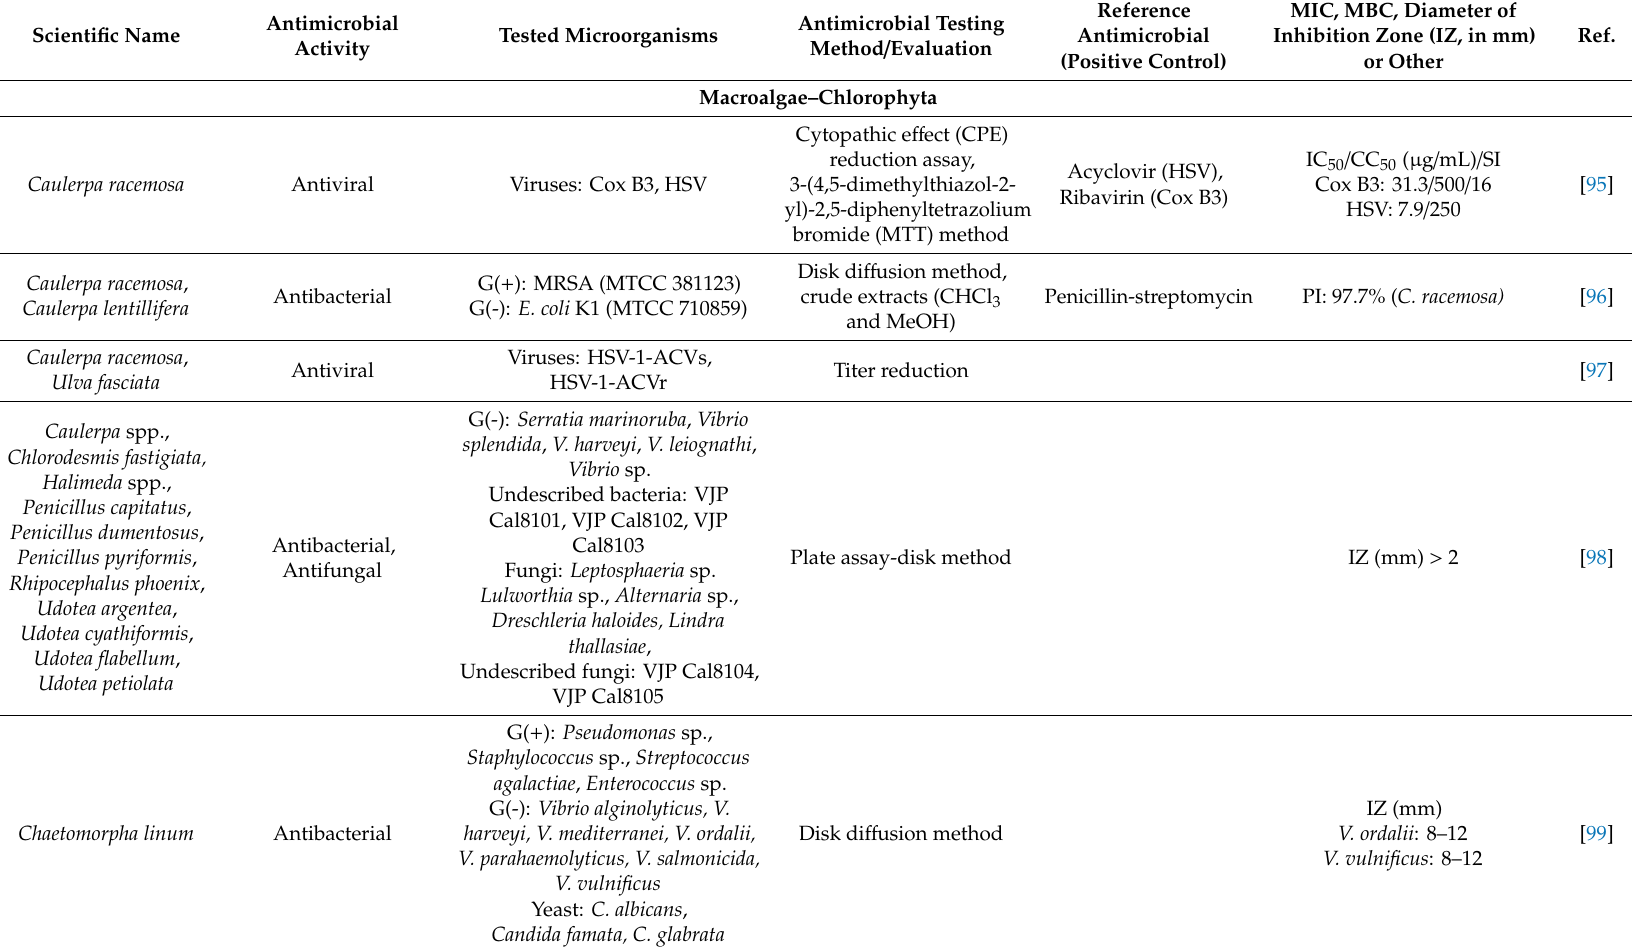
Table 4. Antimicrobial activity of algae lipids or algae lipid-rich